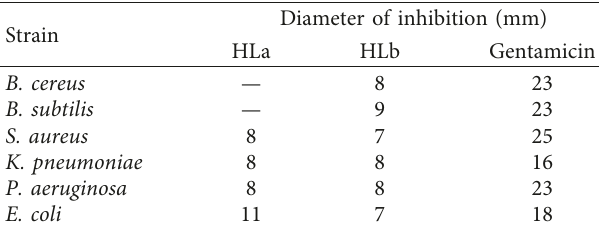
Table 3: Relative diameter of the inhibition zone exhibited by the ligands HLa and HLb.